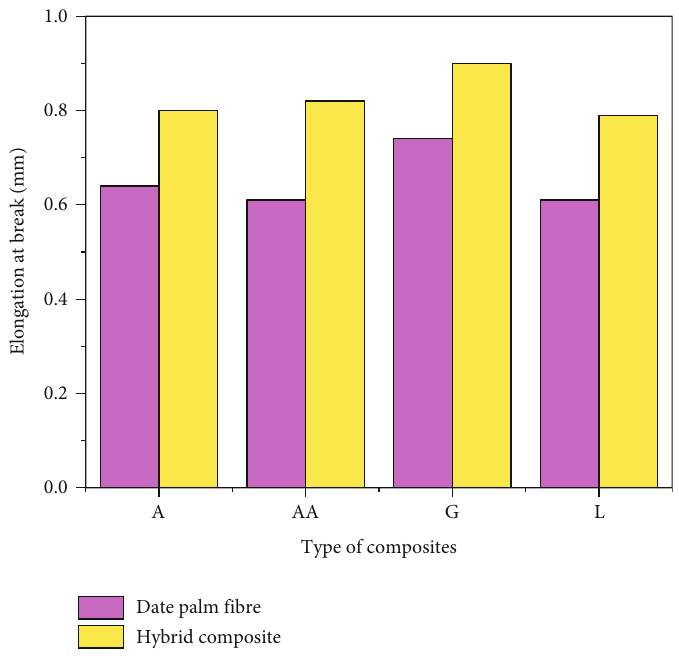
Figure 8: Elongation at break of DPF and hybrid composite fi ber.